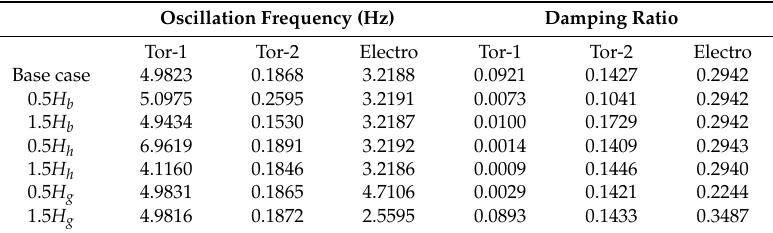
Table 4. Impact of the inertia